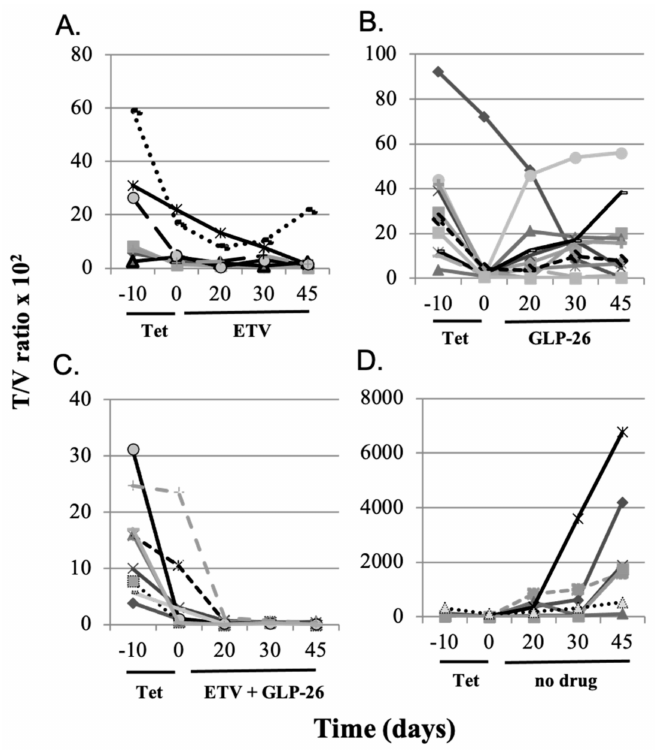
Figure 1. HBV titers (DNA copies/mL serum per mm 3 tumor (T/V ratios) × 10 2 ) of individual nude mice bearing HBV-infected AD38 xenografts. Mice in all groups were given TET in their drinking water from day minus 10 to day 0. On day 0, TET was replaced with the following treatments: ( A ) continuous ETV from day 0 to day 45, ( B ) continuous GLP-26 from day 0 to day 45, ( C ) continuous ETV + GLP-26 from day 0 to day 45, and ( D ) no drug was provided from day 0 to day